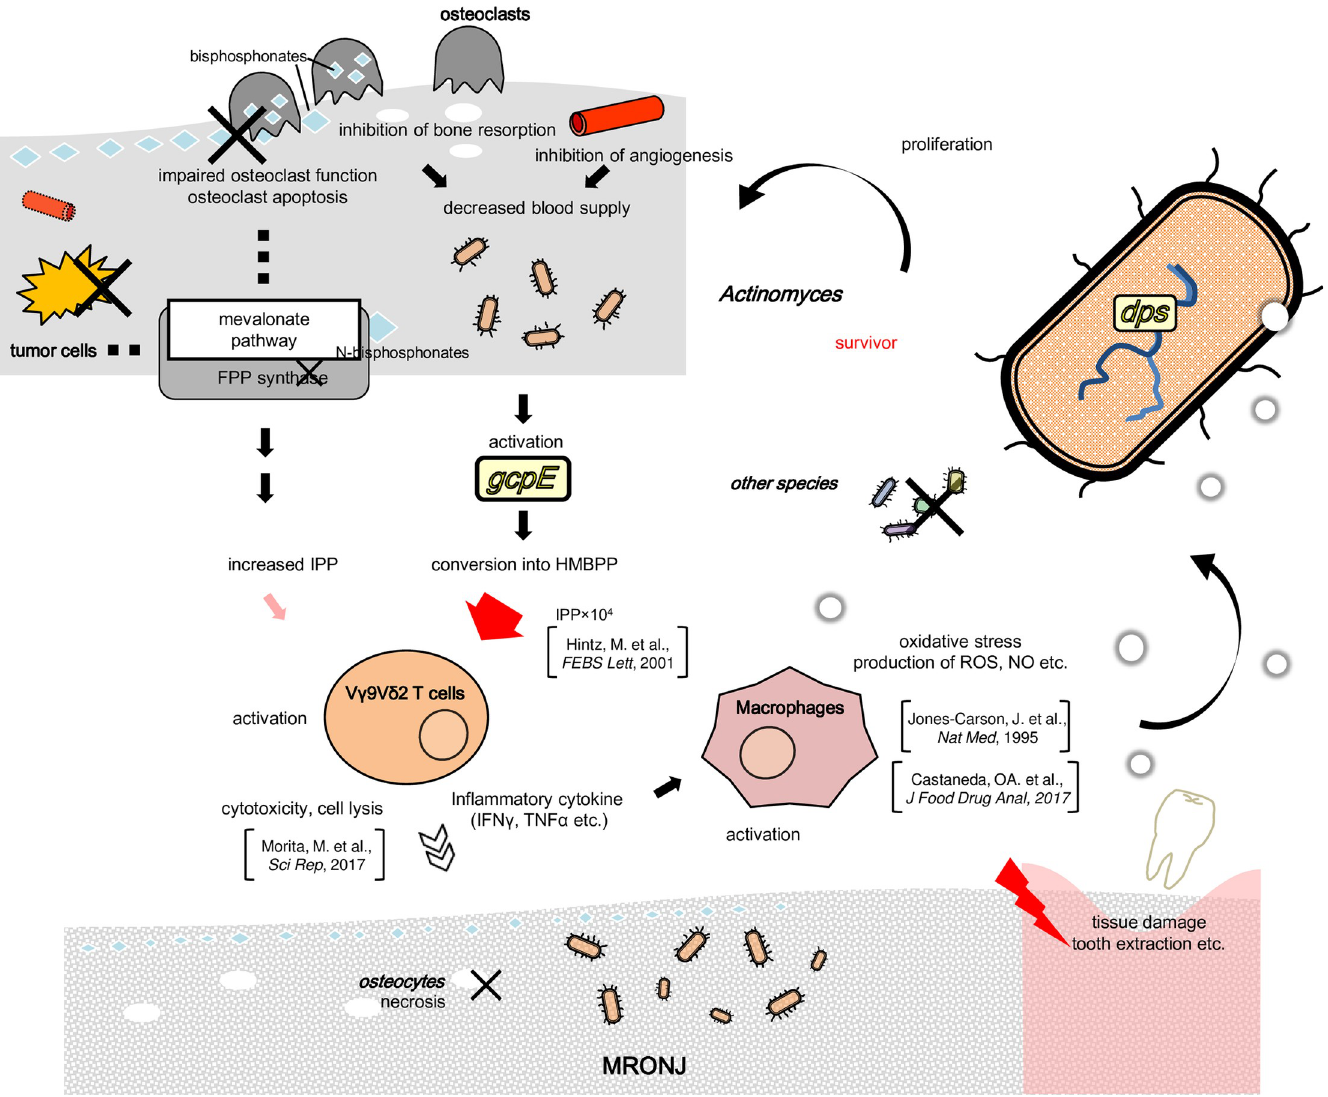
Fig 5. Schematic representation of potential relationships between the 4 MRONJ-associated genes and the disease at the molecular level. The 4 genes are indicated as yellow circles. Abbreviations: FPP: farnesyl diphosphate, HMBPP: (E)-4-hydroxy-3-methylbutyl-2-enyl pyrophosphate, IPP: isopentenyl diphosphate, NO: nitric oxide, and ROS: reactive oxygen species. Bisphosphonates and other drugs could trigger osteosclerosis or block angiogenesis. GcpE synthesizes HMBPP and is usually functionally inactivated by dioxygen. The gene could be activated under the condition of the lack of blood supply. HMBPP activates V γ 9V δ 2T cells. The effect is 10 4 greater than IPP that is accumulates when bisphosphonates are used. V γ 9V δ 2T cells have strong cell lytic activity to induce osteocyte apoptosis and secretion of cytotoxic substances, which can lead to MRONJ. Activated cells also produce inflammatory cytokines, such as tumor necrosis factor-alpha (TNF- α ) and interferon- gamma (IFN- γ ). This strong local inflammation can activate macrophages, which produce reactive oxygen species (ROS) and nitric oxide (NO). ROS and NO are capable of damaging DNA, proteins, and other cellular compartments, and can impose potentially lethal stress on bacteria. Actinomyces can survive and proliferate, whereas the other bacteria have no defenses and decrease in